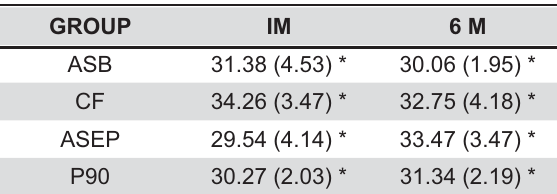
Table 1- Mean (standard deviations) of bond strength of experimental groups. Similar results are shown at *(p> 0.05)